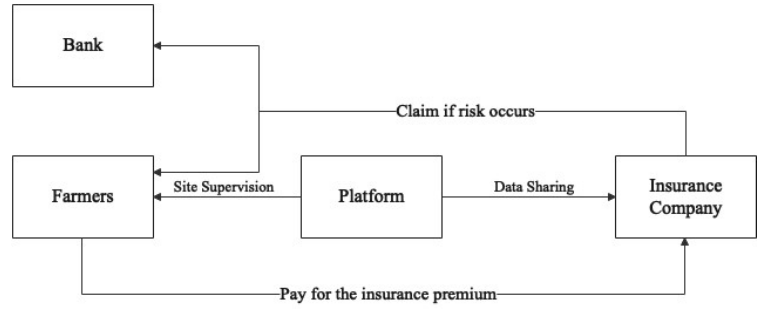
Figure 7. Platform insurance model.